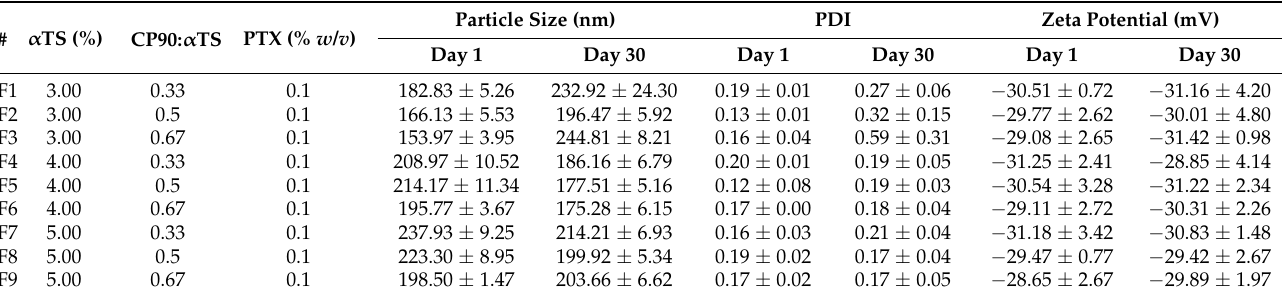
Table 3. Formulation compositions for optimization of the lipid content and lipid ratio.